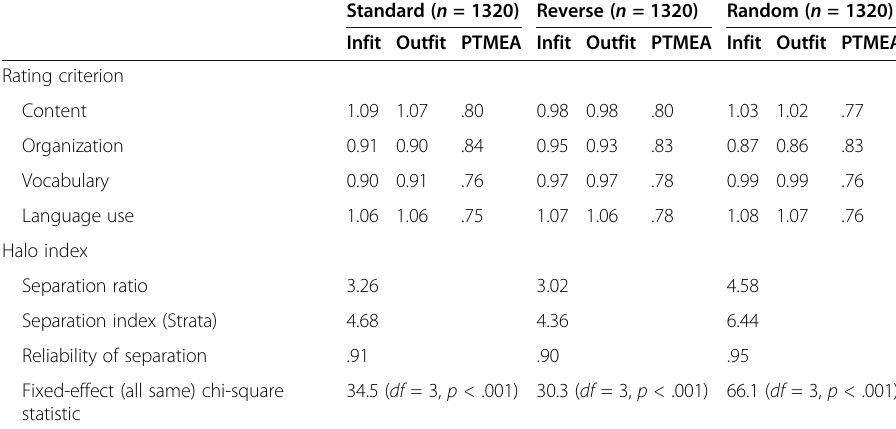
Table 11 Rasch summary statistics of novice ratings